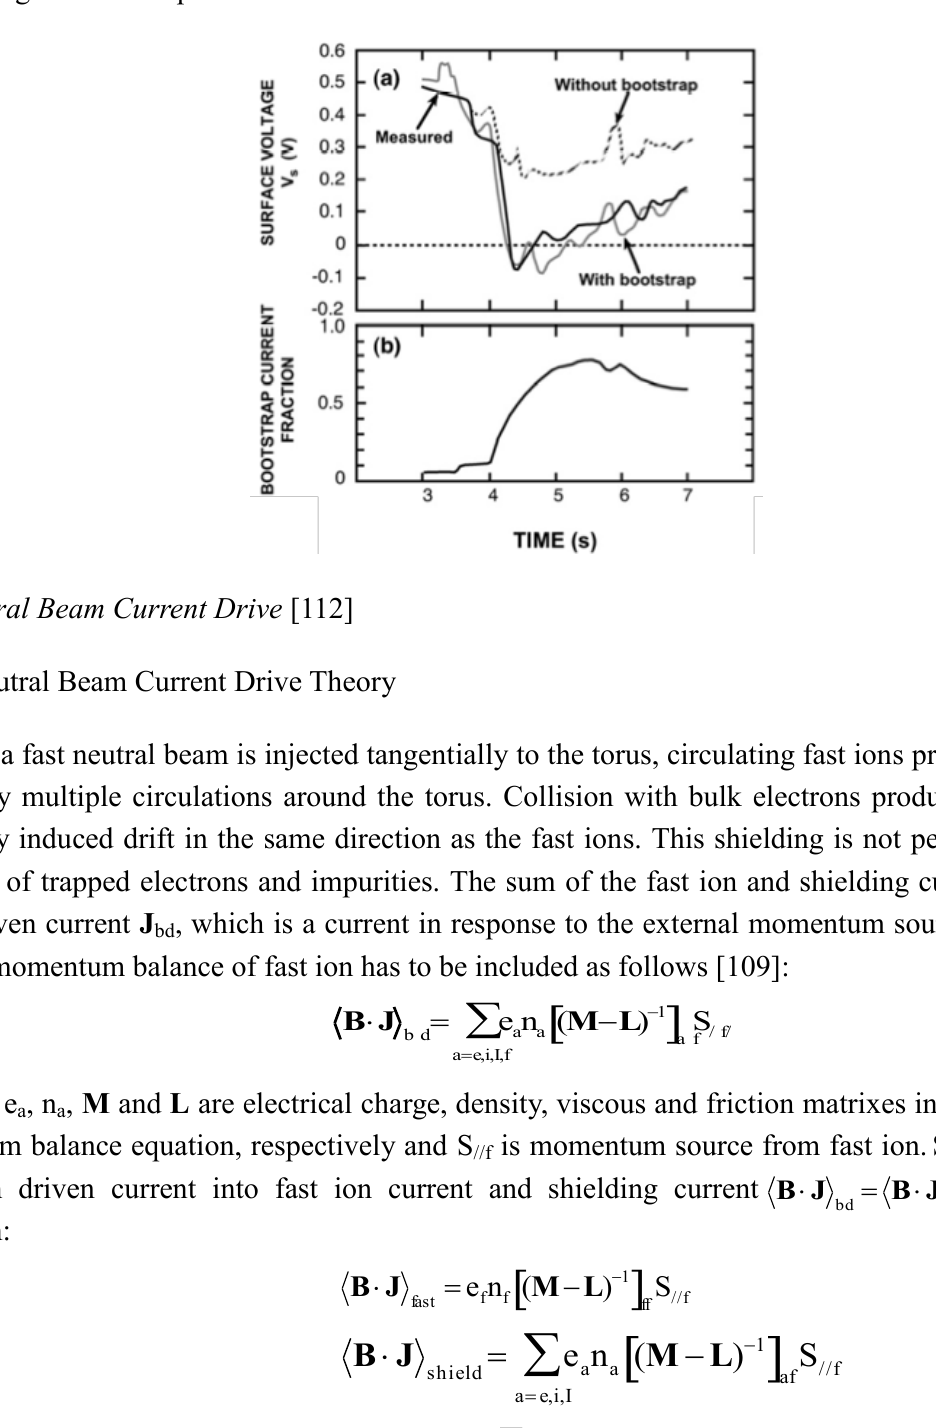
Figure 21. Comparison of time variation of measured surface voltage and simulation using (42) of JT-60 discharge [109]. Up to 80% of the plasma current is carried by the bootstrap current from the simulation. Without including bootstrap current, the measured surface voltage can’t be